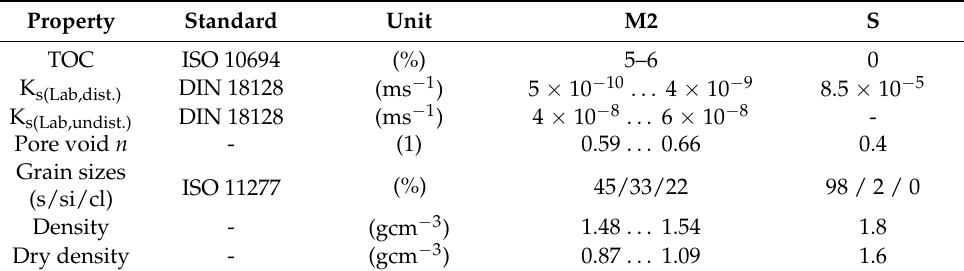
Table 1. Properties of dredged material M2 and sea sand S [8]. Property Standard Unit M2 S TOC ISO